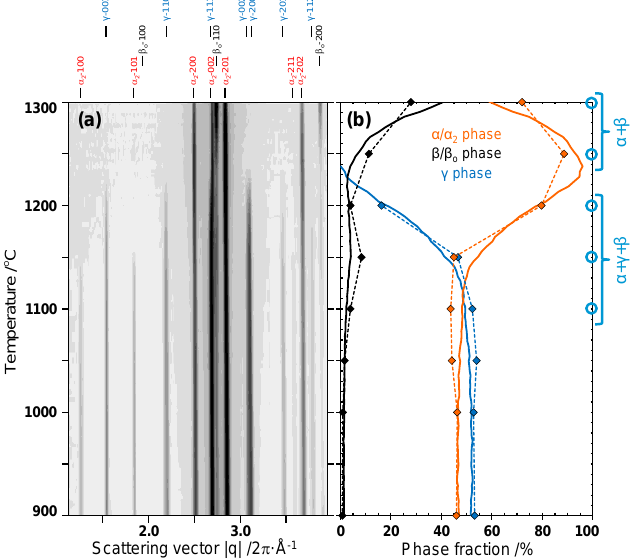
Figure 2. Phase constitution as a function of temperature for Ti-42Al-8.5Nb. ( a ) Evolution of the diffraction patterns during heating; ( b ) Phase fractions determined by Rietveld analysis. Continuous lines: heating rate of 10 °C·min −1 . Dashed lines: stepwise